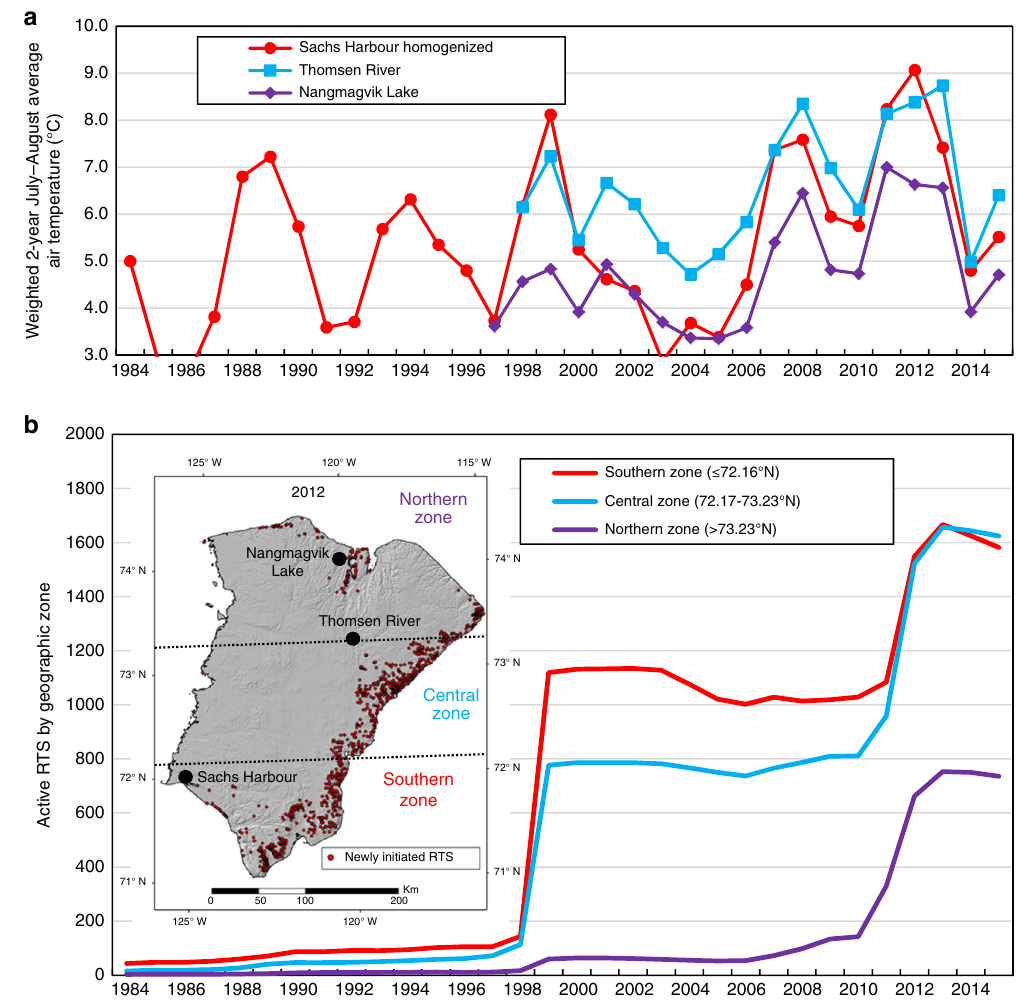
Fig. 6 Spatial response of retrogressive thaw slump initiation to differential warming. a Weighted 2-year July – August average air temperature at three of fi cial climate stations on Banks Island: Sachs Harbour (1984 – 2015), Thomsen River (1998 – 2015) and Nangmagvik Lake (1997 – 2015). b Total active retrogressive thaw slumps in southern ( ≤ 72.16°N — red line), central (72.17 – 73.23°N — blue line) and northern (>73.23°N — purple line) zones. Inset map shows the boundaries of the three zones, the location of the three climate stations, and retrogressive thaw slumps fi rst observed in